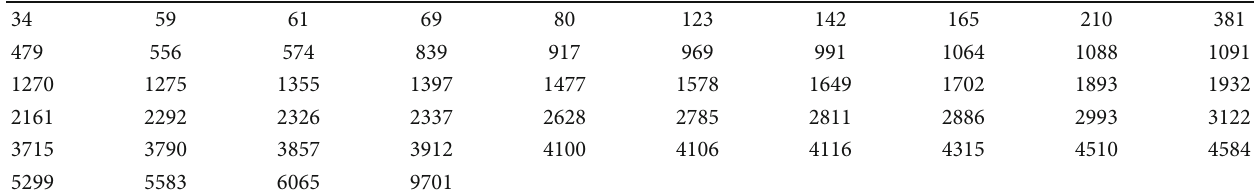
Table 2: Failure time of electrical appliances in terms of 1000s